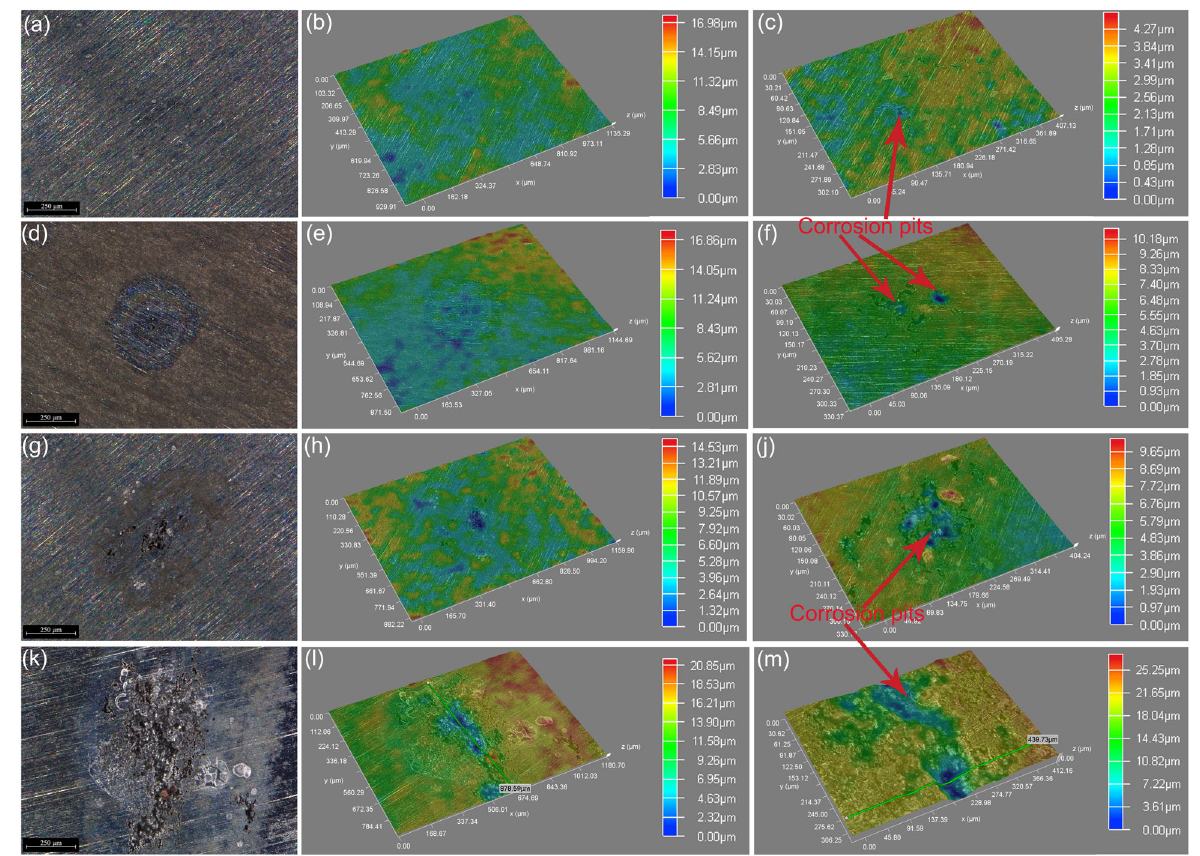
Fig. 2 The 2D and 3D surface morphologies of specimens after removing bio fi lms corresponding to different initial spore concentrations of A . terreus with continued organic carbon starvation. a – c control, d – f 10 4 spores mL − 1 L, g – j 10 6 spores mL − 1 , k – m 10 8 spores mL − 1 . Images of c , f , j , m are the part enlarge of images of b , e , h and l